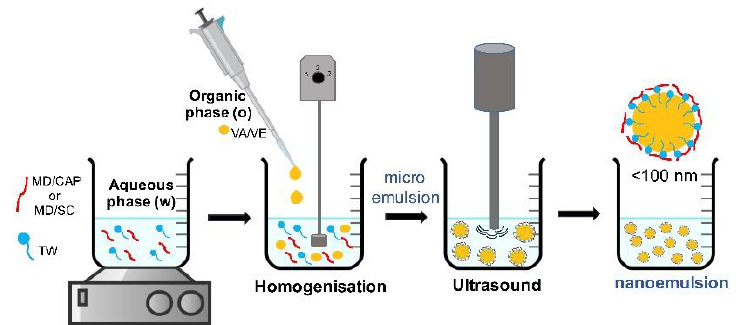
Figure 7. Nanoemulsion preparation sequence.